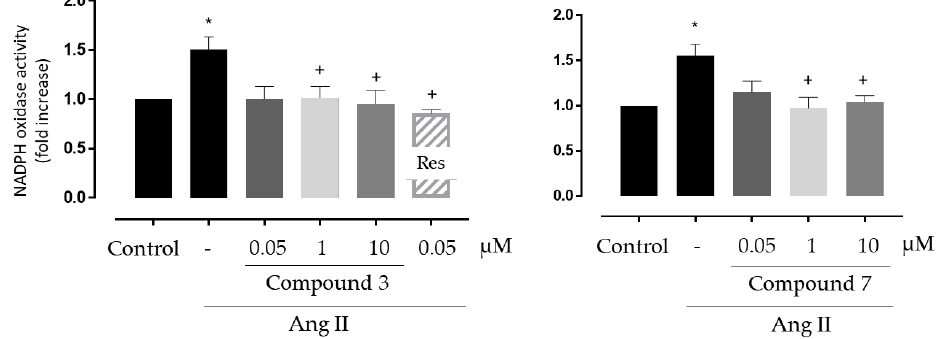
Figure 2. Effect of compounds 3 and 7 on Nicotinamide Adenine Dinucleotide Phosphate (NADPH) oxidase activity induced by Angiotensin II (Ang II) in cultured human microvascular endothelial cells. * p < 0.05 vs. control, + p < 0.05 vs. Ang II. Res: resveratrol (dashed bars) was used as positive control. N = 8 for compound 3 and n = 7 for compound 7 .